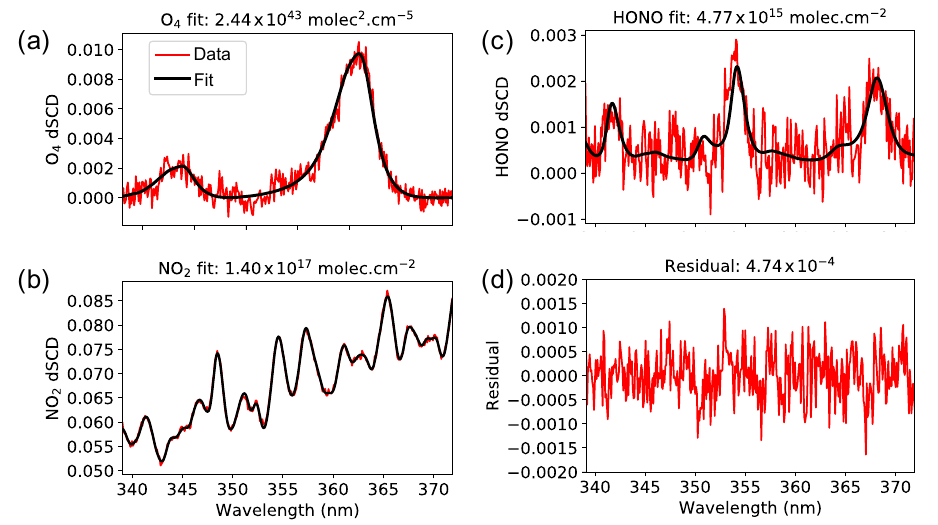
Figure 2. Example DOAS fit results for a 2 ◦ elevation angle and 28 ◦ solar zenith angle on 4 March 2017, showing (a) O 4 and (b) NO 2 in the 338–370nm fitting window, with (c) HONO and (d) fit residual in the 339–372nm fitting